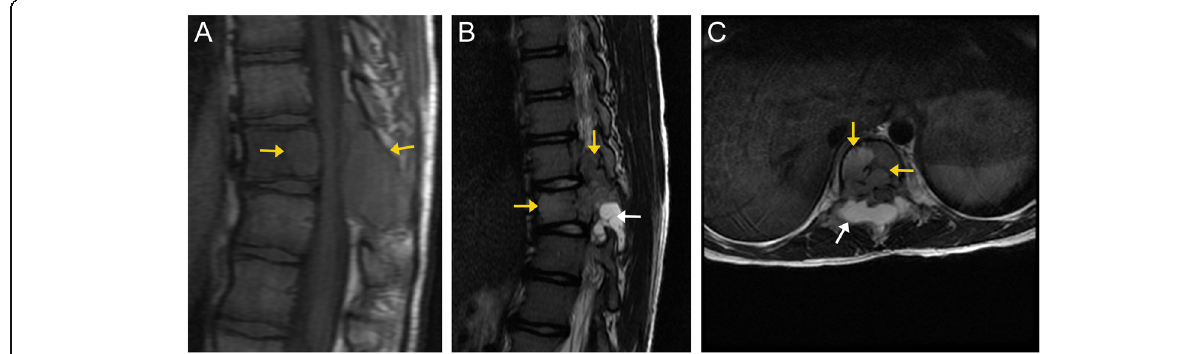
Fig. 8 Osteoblastoma. Sagittal T1 weighted MR image ( a ) demonstrates a low signal lytic lesion involving the T10 vertebral body and posterior elements (orange arrows). The lesion is intermediate to high signal on T2 weighted images ( b , c ). There is an associated T2 hyperintense component, consistent with an aneurysmal bone cyst (white arrow), which can be seen in 10-20% cases of